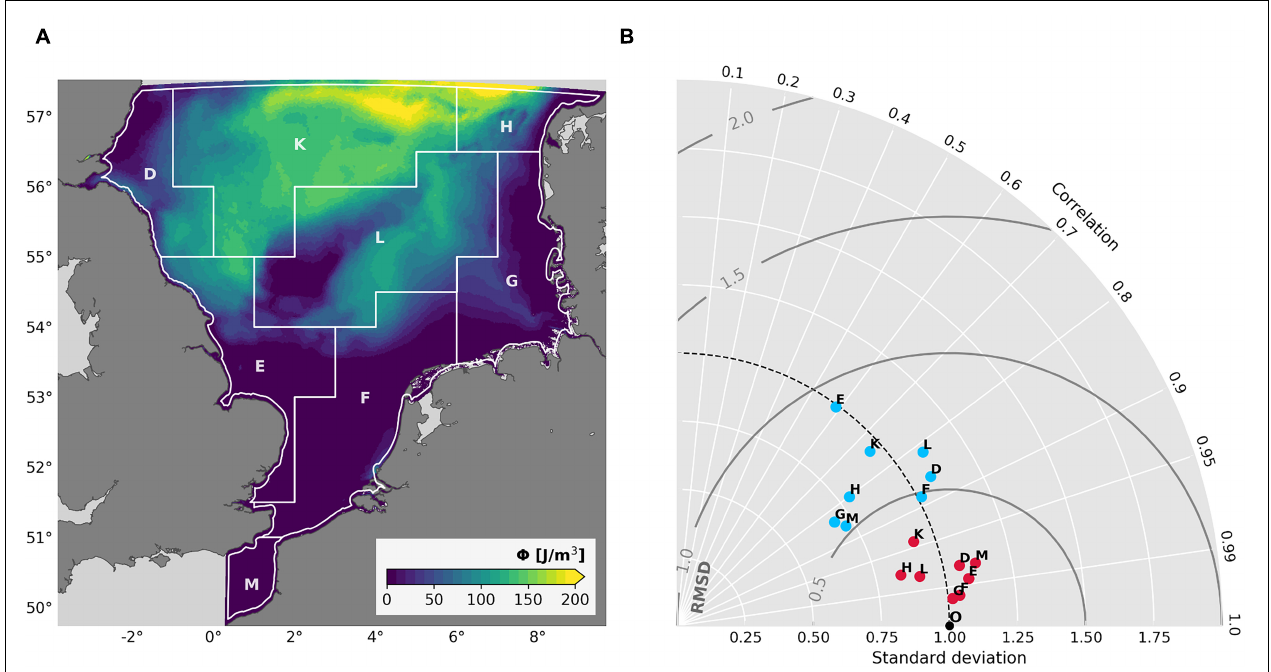
FIGURE 4 | Validation of the spin-up simulation: (A) Mean potential energy anomaly in August and the characteristic subareas for the model validation. Area separation was applied according to Daewel and Schrum (2013). (B) Taylor diagram for depth-averaged temperature (red dots) and salinity (blue dots) in the different subdivisions of the model domain with respect to the observation statistics. O, observation